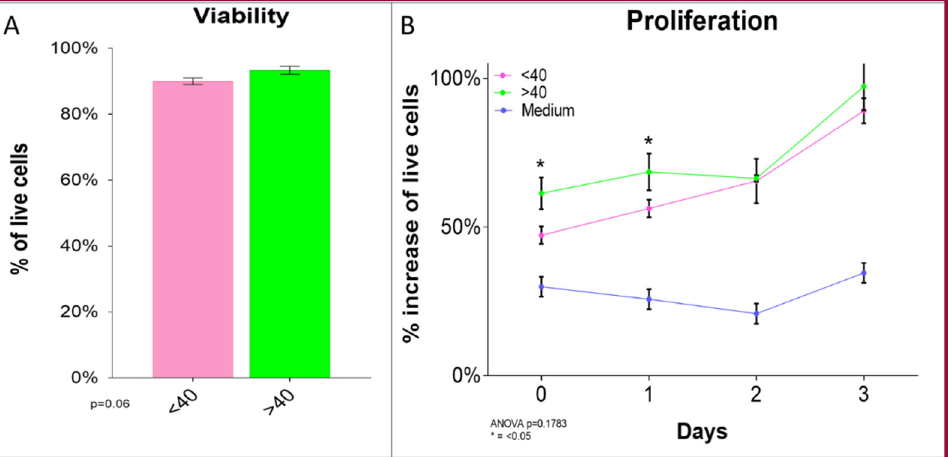
Figure 2. Comparison of hOMSCs among age groups. In samples obtained from healthy donors, ( A ) viability was over 90% for both age groups (<40 years old and >40 years old) with no significant difference between them. ( B ) In the proliferation assay, there was a slight difference on day one, but at day 3, there were no differences between age groups (<40 years old and >40 years old). (Bars represent mean ± SEM), p < 0.05 was considered significant, n = 3 per group).